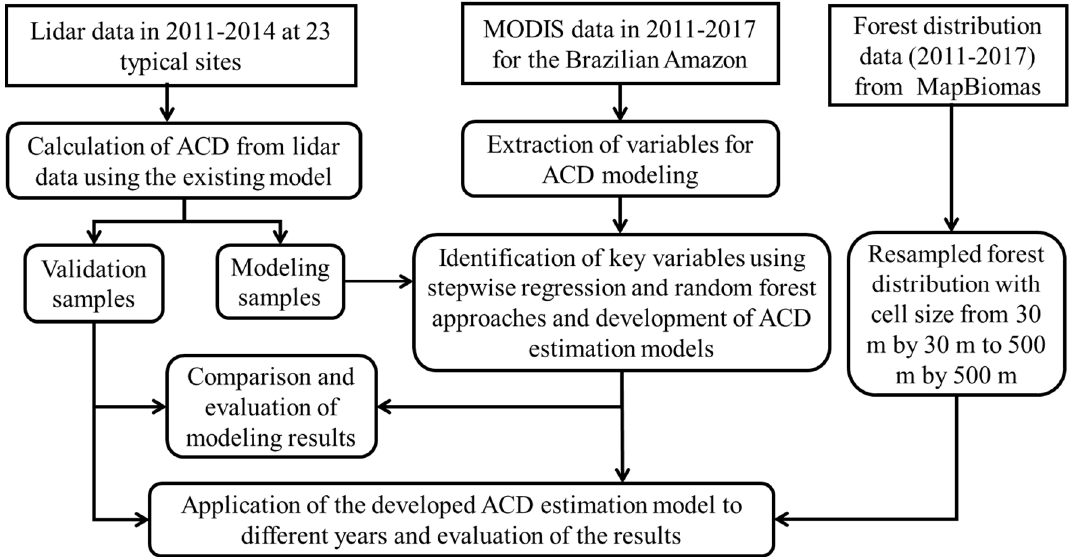
Figure 2. Strategy of mapping aboveground carbon density (ACD) distribution in the Brazilian Amazon basin using MODIS and LiDAR data.